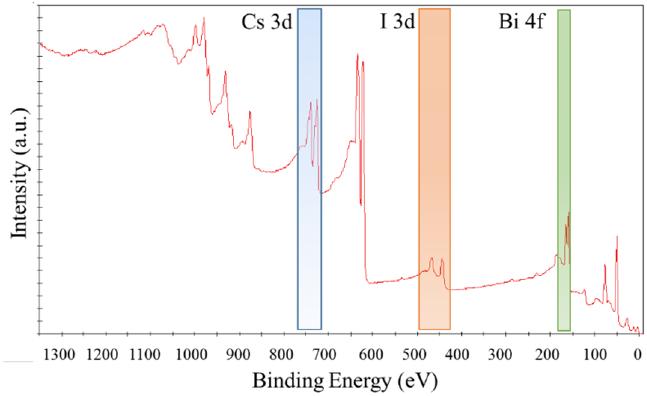
Figure 4. XPS survey spectrum.